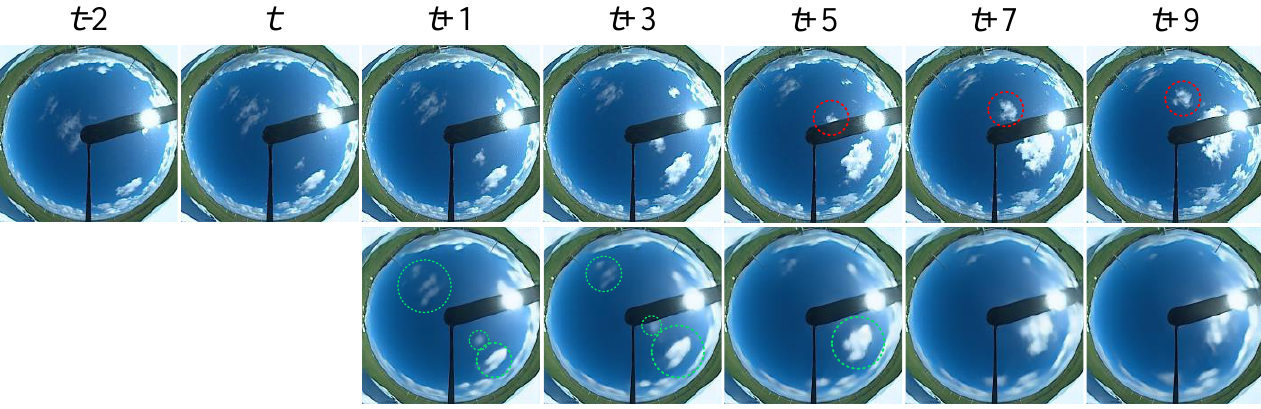
Figure 13. An example of the cloud motion prediction results. The first row is the ground truths, and the second row is the corresponding prediction results. For ease of presentation, some moments have been omitted. The prediction is started at step t .